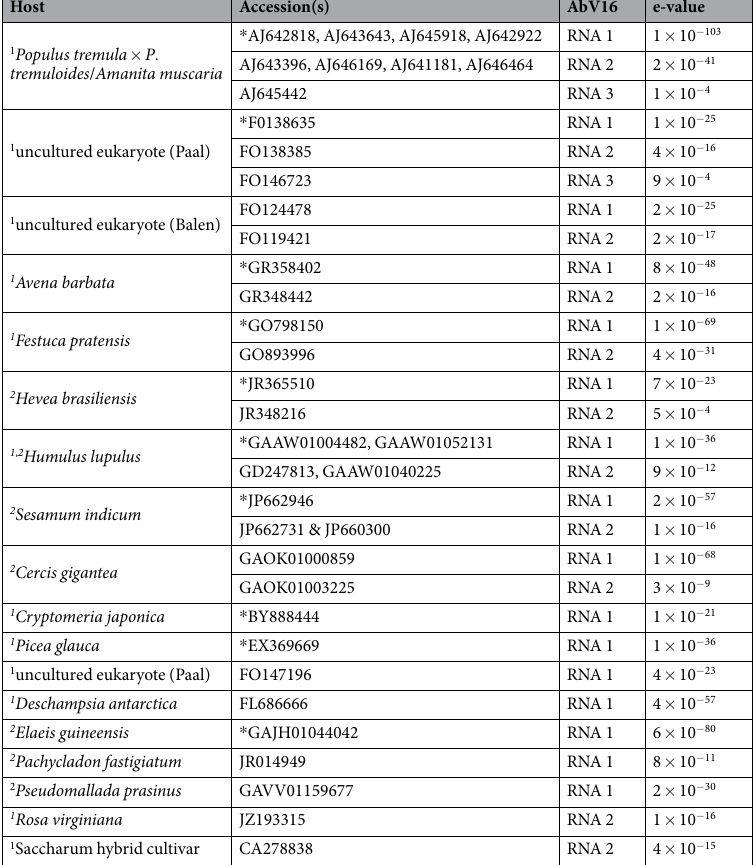
Table 3. Homologs and proposed members of the Ambsetviridae family of AbV16 with an e-value < 10 − 3 identified in NCBI Expressed Sequence Tag and Transcriptome Shotgun Assembly databases with BLASTP. The Host column corresponds to the organism (if known) from which RNA was extracted. The Accession column corresponds to the GenBank accession(s) for the homologous sequence. The AbV16 column lists the AbV16 RNA to which the homolog was found and the e-value column lists the BLASTN e-value. * Indicates used in construction of phylogenetic tree (Supplementary Figure S5). 1 Sequence found in Expressed Sequence Tag database. 2 Sequence found in Transcriptome Shotgun Assembly